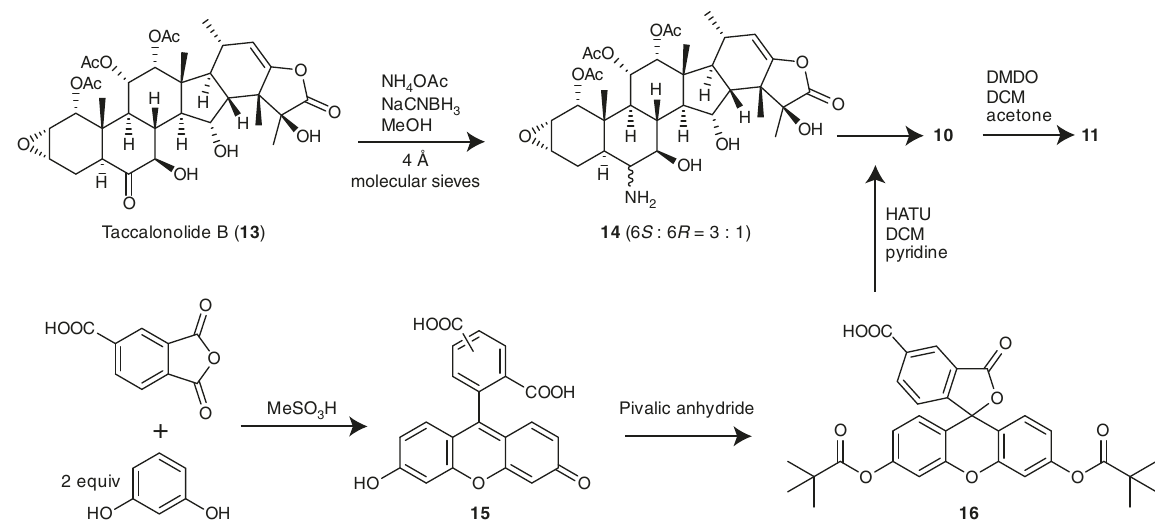
Fig. 3 Synthesis of Flu-tacca-7 (11). The synthetic scheme for the generation of the most potent dipivaloyl-protected taccalonolide fl uorescent probe. Detailed methods can be found in Supplementary Methods.